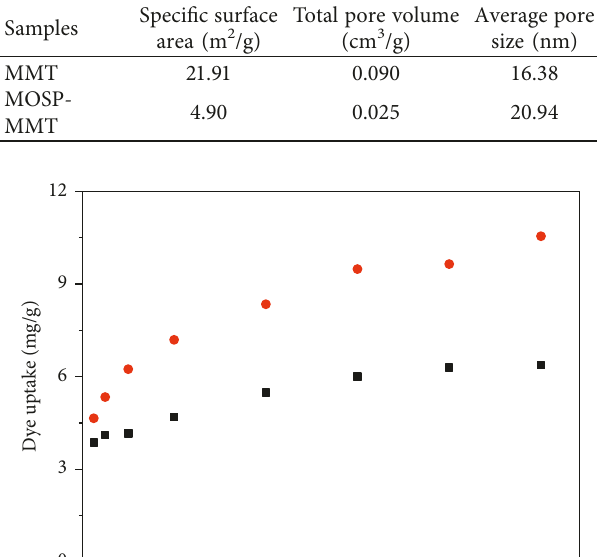
30 ° C and (cid:31)